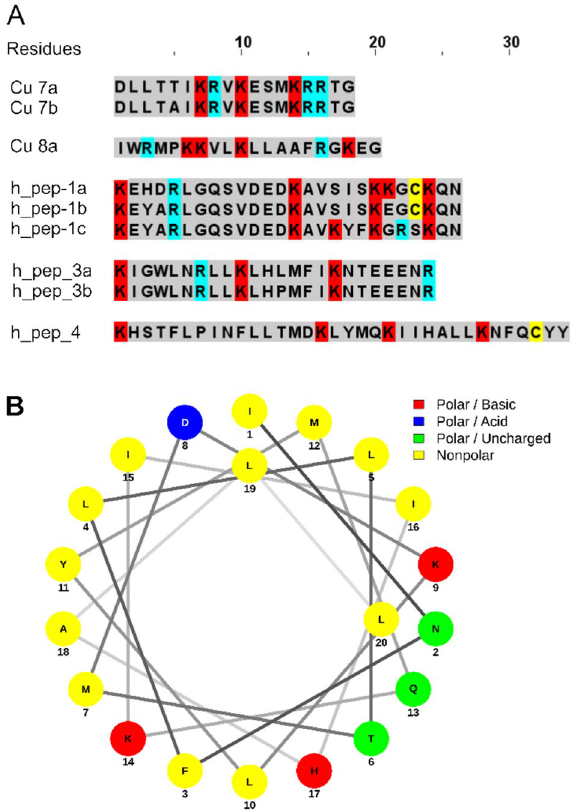
Figure 7. Overview of Cu 7, 8, and hypothetical peptides families identified by 454-seq in the transcriptome of C. salei. ( A ) Amino acid sequences of Cu 7, 8, and of the hypothetical peptide families 1, 3, and 4. Cationic amino acids are marked in red (Lys) and blue (Arg), and Cys in yellow. ( B ) α-helical wheel projection 27 of the proposed α-helical part (Ile 8 –Leu 27 ) of